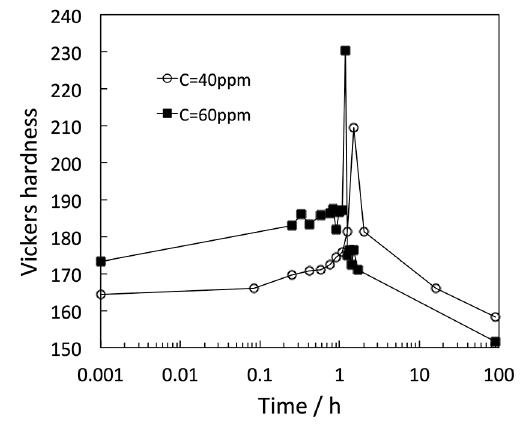
Figure 2. Vickers hardness evolution (1kg load) of the samples with 40 and 60ppm C aged at 200 and 225°C, respectively.